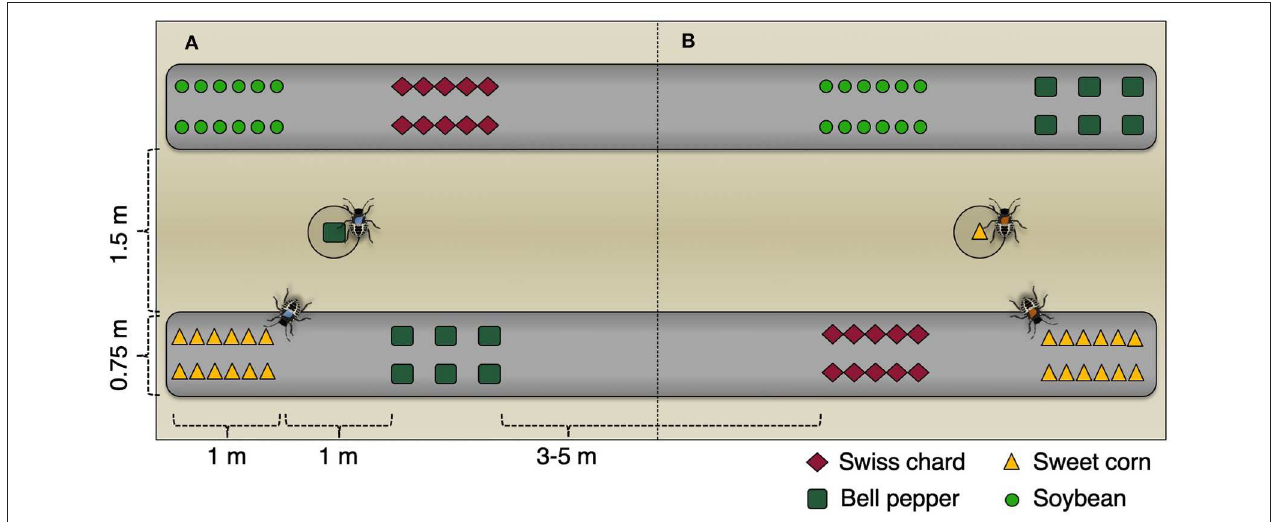
FIGURE 1 | Example field layout of two (A,B) of the 16 experimental plots, illustrating the positioning and spacing of the sub-plots.